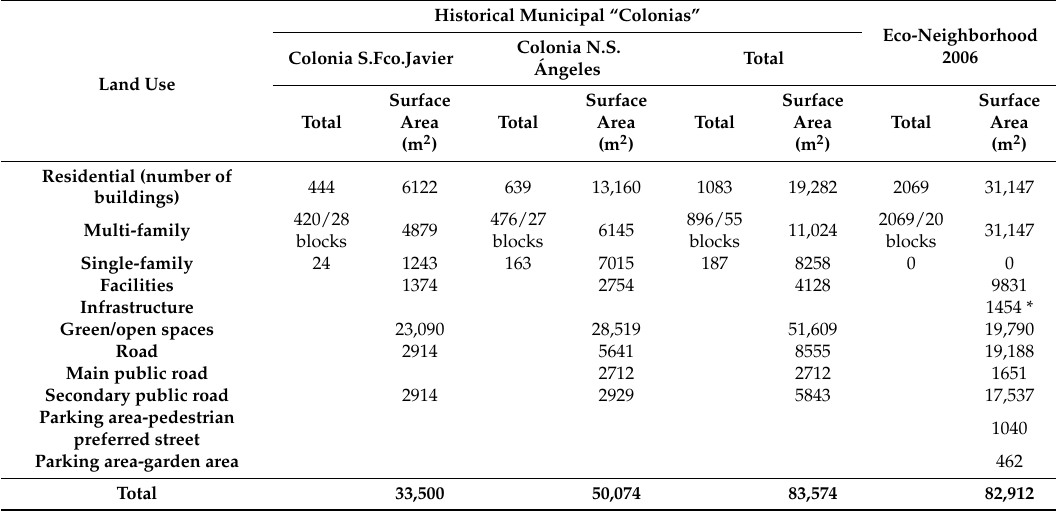
Figure 6. Top : Map of the eco-neighborhood included in the 2010 environmental improvement plan; bottom : Map of the old “colonias municipales”. Source: See Table 2. Table 2. Comparison of land use in the San Francisco Javier and Nuestra Señora de los Á ngeles communities through the eco-neighborhood project. * Eco-neighborhood facilities: Heating-hot water and solid waste collection, 1067 m 2 ; energy transformation center, 353 m 2 ; fuel supply, 33 m 2 . Source: Municipal data on said communities in cadastral map 1982 and 2006. EMVS